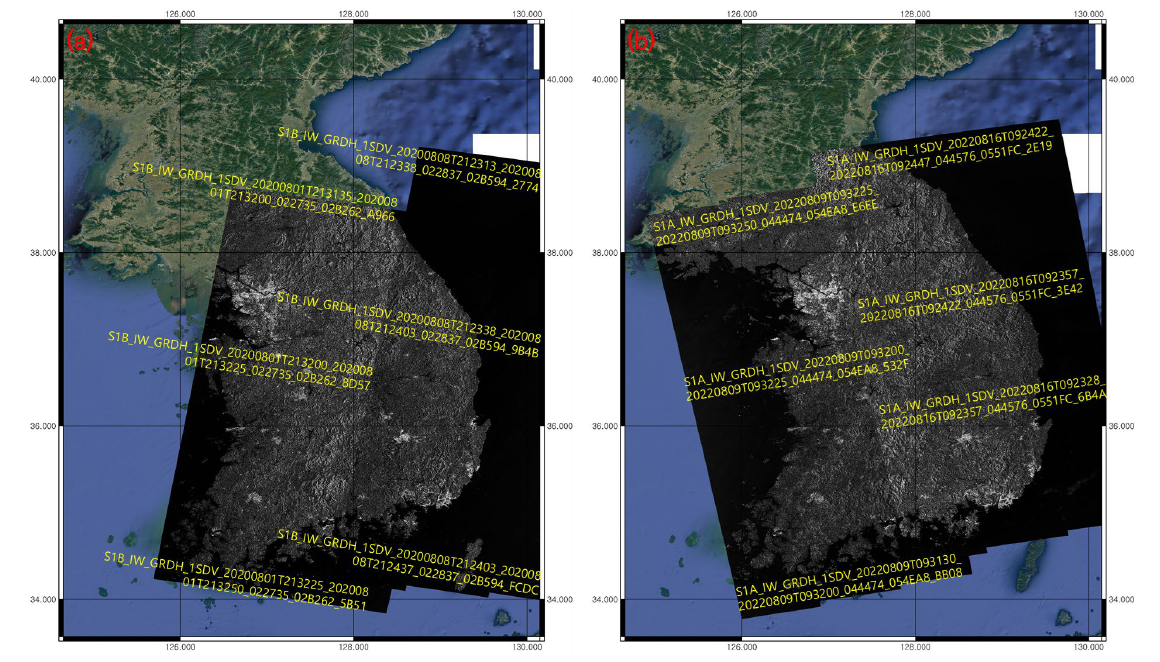
Figure 6. Sentinel-1 images for the two major flood events in August in ( a ) 2020 and ( b ) 2022. Table 2. Selected Sentinel-1 images for evaluating deep learning-based image segmentation for the fully automated flood monitoring system.